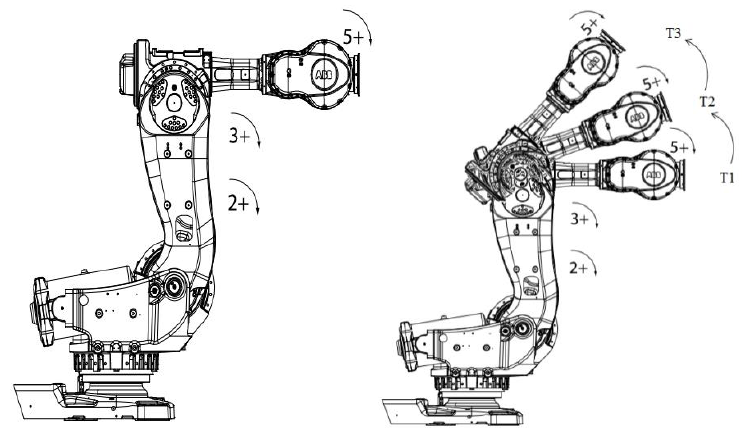
Figure 4 . Interacting ABB - IRC5 robotic arms in an adjustment environment [ 22 ]. Figure 4. Interacting ABB-IRC5 robotic arms in an adjustment environment Table 1. K - means clustering based on EEG Poisson distribution approximation (PDA) sampling data ( left - hand rise ).